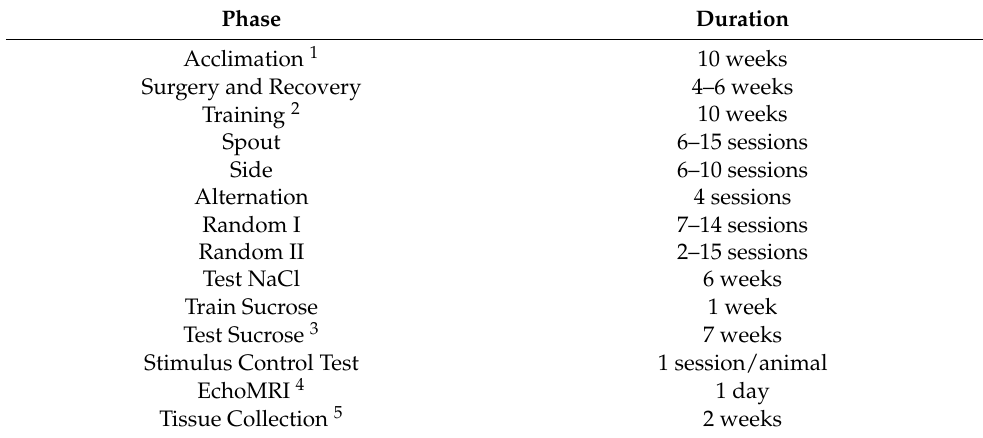
Table 1. Timeline